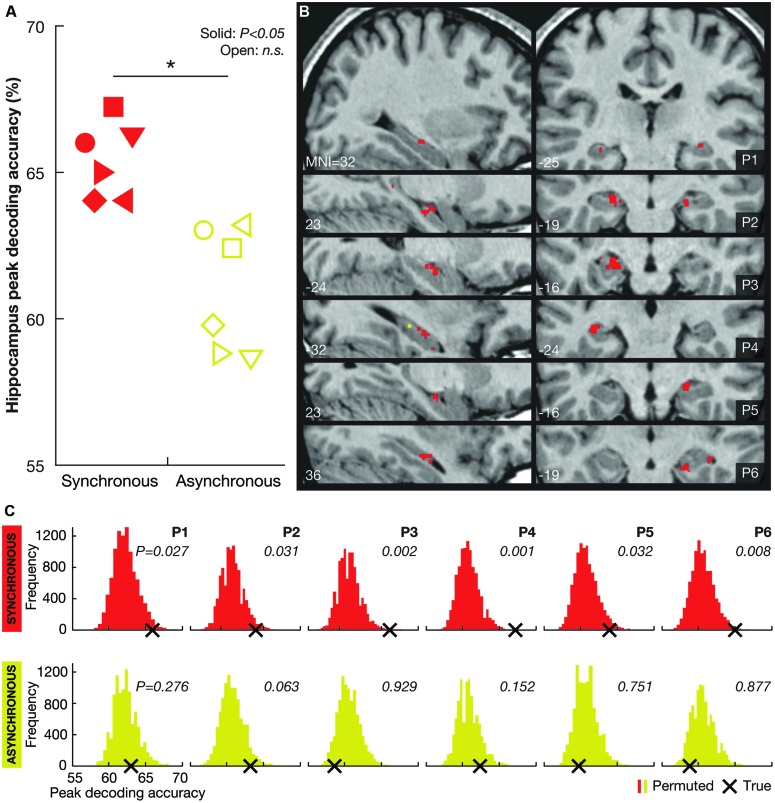
Decoding results. (A) Individual peak decoding accuracies for the synchronous (illusion; red symbols) and the asynchronous (control; yellow symbols) conditions. The symbols indicate each participant (female participants are represented by triangles). A solid symbol represents a significant value (P < 0.05, corrected) and an open symbol represents a non-significant (n.s.) value (P > 0.05, corrected). At the group-level, the peak decoding accuracy was significantly higher in the synchronous than in the asynchronous condition (*P = 0.012). (B) Maps illustrating the localization of voxels informative about self-location during the synchronous (red) and asynchronous (yellow) conditions (P < 0.001, uncorrected) for each participant (P1–P6). Note that there were significantly fewer (or no) such voxels in the asynchronous condition (mean number of voxels ± SD: 2.0 ± 2.9) than in the synchronous condition (mean number of voxels ± SD: 32.3 ± 15.4; P < 0.05, two-tailed Wilcoxon signed-rank test). At the group-level, there were no significant differences among the hippocampal subregions (right anterior, right posterior, left anterior, left posterior; χ2(3) = 1.316, P = 0.725, Freidman test) in the number of informative voxels. (C) Permutation testing. The histograms indicate the participantwise distributions of peak decoding accuracies under the null hypothesis that there was no information regarding LOCATION A and LOCATION B encoded in the hippocampus for the synchronous (red) and asynchronous (yellow) conditions (permutation testing with 10,000 iterations). The frequency of permuted (randomly labeled) decoding maps (Y axis) is presented as a function of the peak decoding accuracy (X axis). The true peak decoding accuracy is indicated with a black cross (corresponding to the symbols shown in A). The probability of obtaining the true value under the null hypothesis (i.e., the P-value) is displayed for the synchronous and asynchronous conditions for each participant.